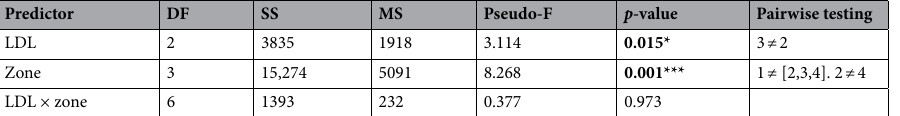
Table 2. Results of multivariate PERMANOVA testing effects of lockdown levels (LDL), zones and their interaction on shorebird assemblage structure in Muizenberg beach. Significant p -values are shown in bold ( p < 0.05*, p < 0.001***). Results of pairwise testing are shown in the far right column in cases where significant predictor effects were detected. Data from 2020, lockdown levels 3-1, were used in the analysis.